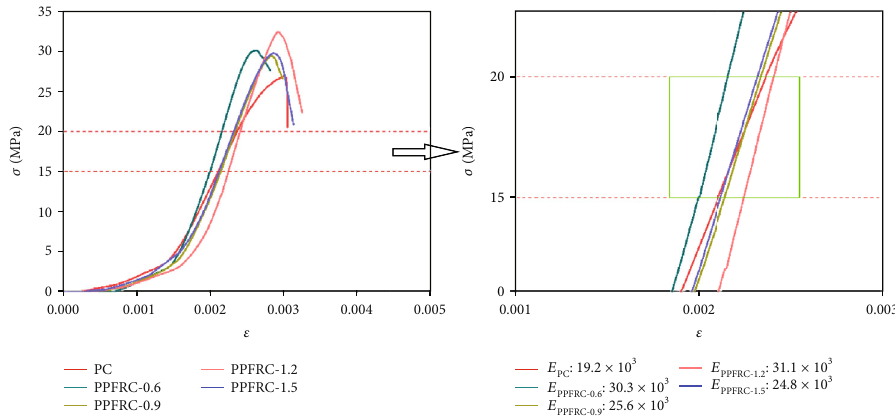
Figure 18: Uniaxial compressive stress-strain curve of PC and PPFRC at 14-day curing age.